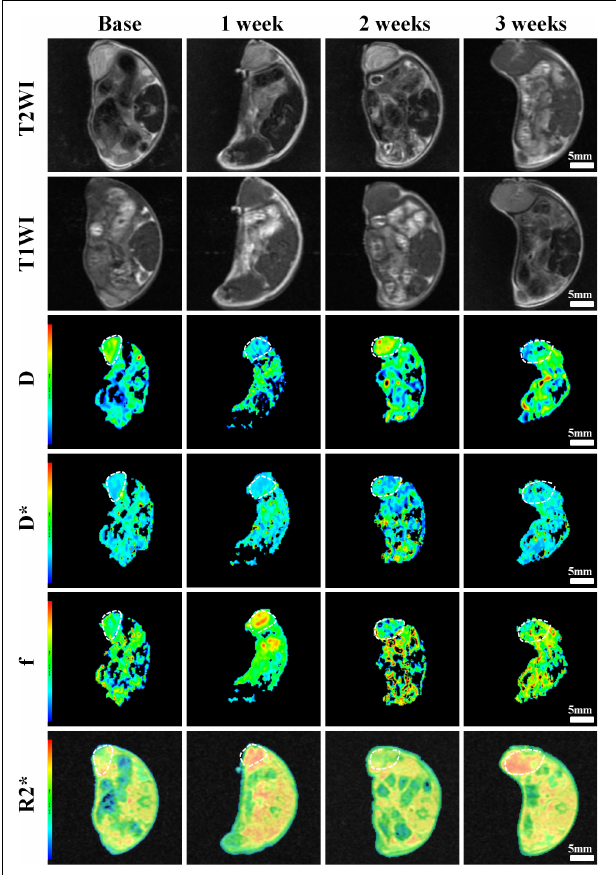
FIGURE 6 | Axial T1WI, T2WI, and pseudocolor maps of D, D*, f, and R2 values at different time points treated with 4 mg/kg of cRGD-PLGA@DOX (Group D). D value is the pure diffusion of water molecule. D* value refers to perfusion-related diffusion. F value is the perfusion fraction. R2* value reflects the tumor hypoxia. The white circles plot the tumor